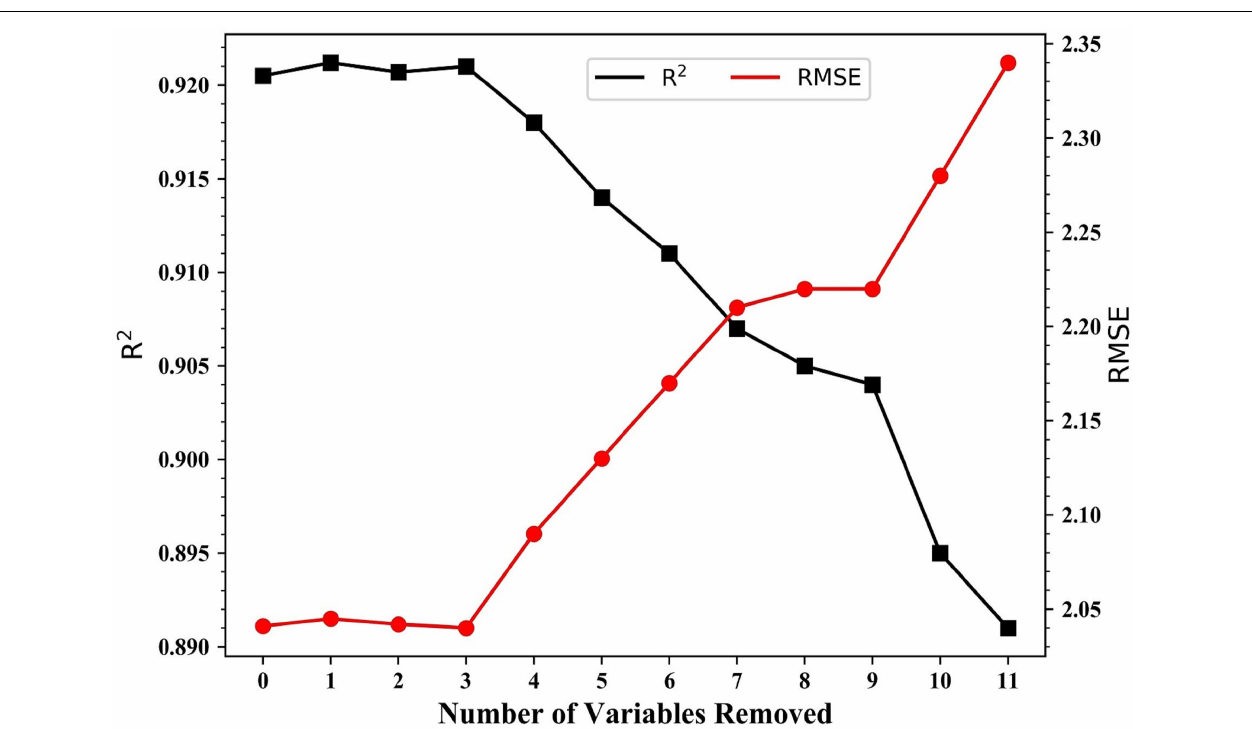
FIGURE 4 | Predictive performance ( R 2 and RMSE) of the random forest model during variable selection. Variables were removed in the order PRS-min, PRS-max, RHU-min, PRE-mean, TEM-mean, WIN-mean, TEM-max, TEM-min, RHU-mean, PRS-mean, and VIS.